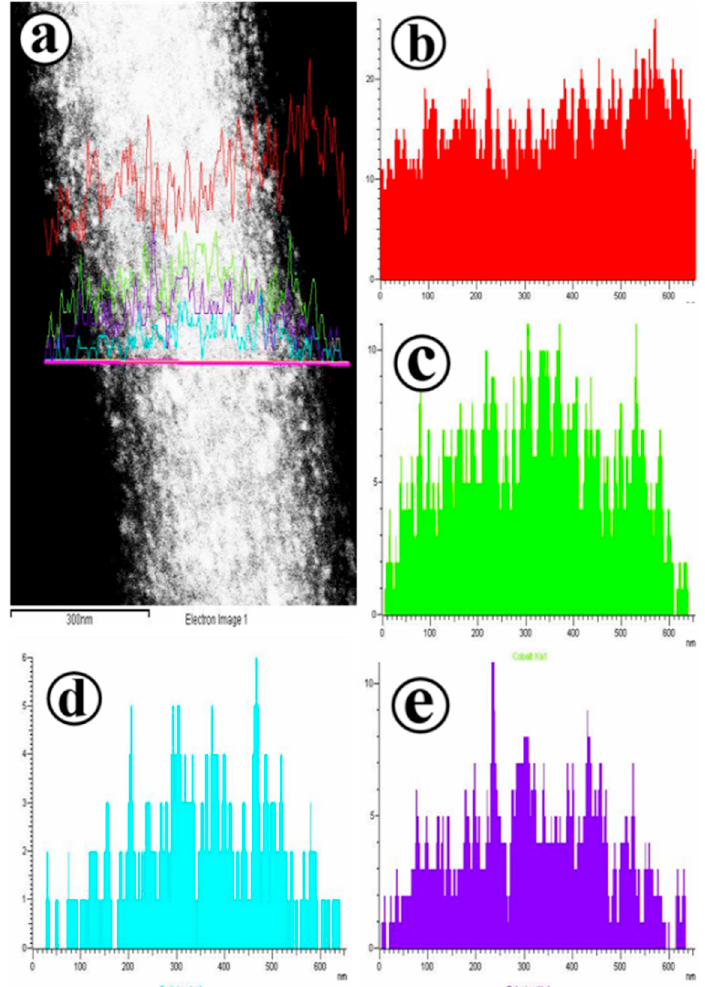
Figure 5. ( a ) Line TEM-EDS of Co-CdSe@ECNFs. Panels ( b–e ) represent line EDS spectra of carbon, cobalt, cadmium, and selenium, respectively.